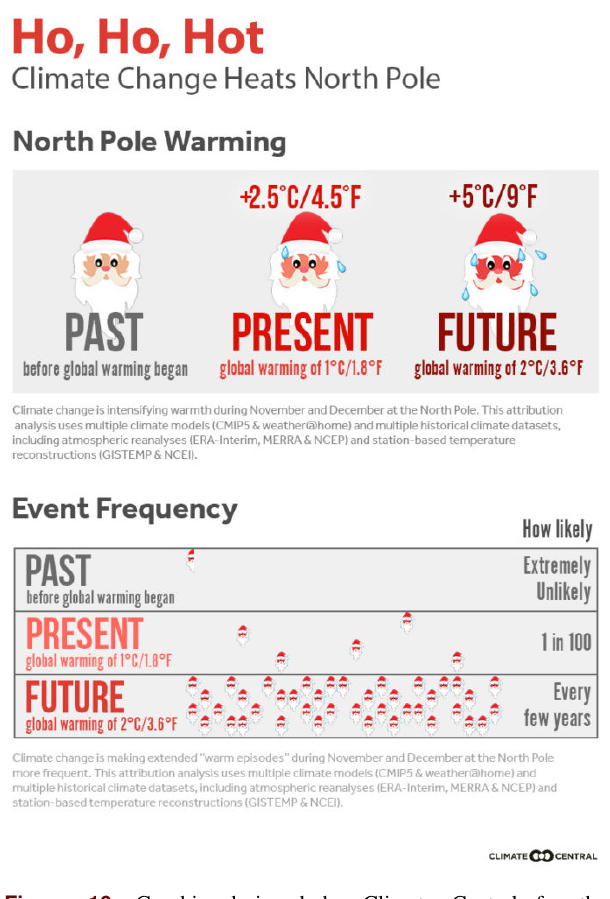
Figure 10. Graphic designed by Climate Central for the November–December 2016 North Pole warmth attribution analy- sis, with changes in intensity and probability visualized for the past, present, and future. From van Oldenborgh et al.